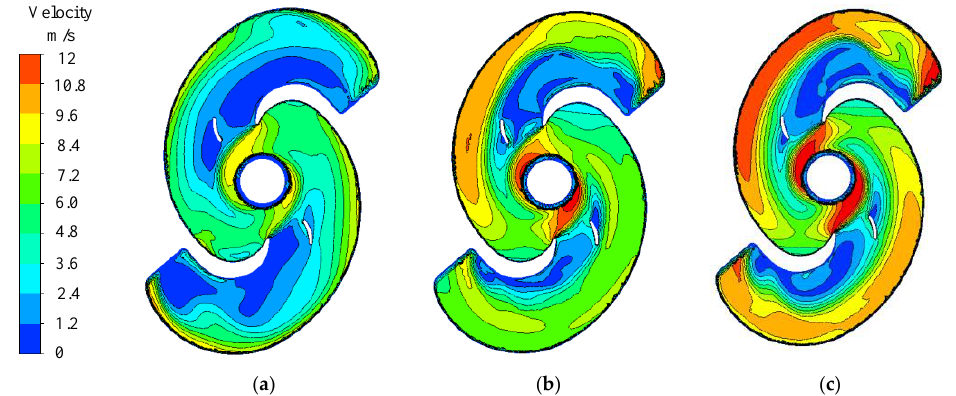
Figure 13. Static pressure distribution in the mid-section of the positive passage at three typical flow rate conditions. ( a ) 0.6 Q , ( b ) 1.0 Q , ( c ) 1.1 Q